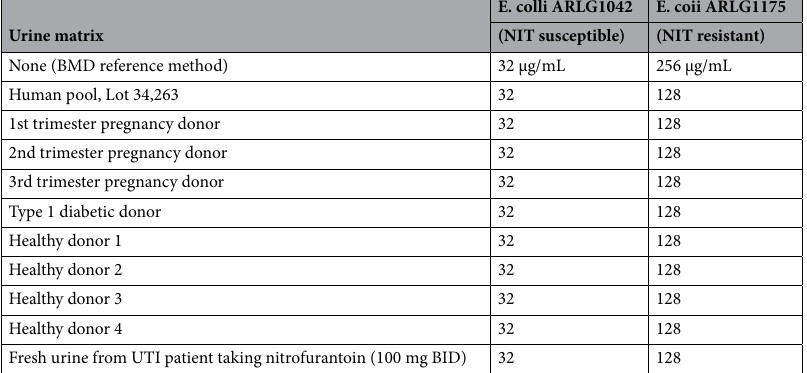
Table 3. MultiPath AST robustness to urine matrix. Urine from a variety of donors was processed, spiked with 5 × 10 5 CFU/mL of a susceptible or resistant E. coli strain, and tested with the MultiPath E. coli AST assay for susceptibility to nitrofurantoin. There was no difference between urine matrices and all MICs were within essential agreement to the BMD reference method. CLSI breakpoints for E. coli with nitrofurantoin are S ≤ 32, I = 64, R ≥ 128